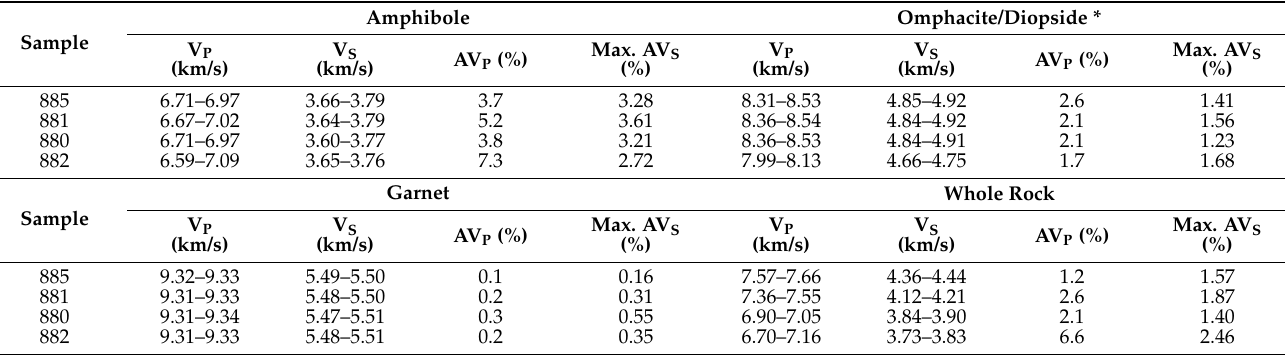
Table 4. Seismic velocity and anisotropy of minerals in samples.